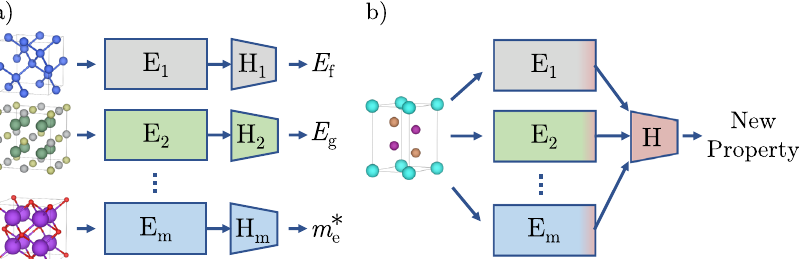
Fig. 1 Overview of our mixture of experts framework. a First, separate machine learning models, each consisting of a feature extractor and a classi fi cation or regression head, are trained on separate learning tasks. b Next, the pre-trained experts are adapted to a downstream learning task along with a newly initialized head.